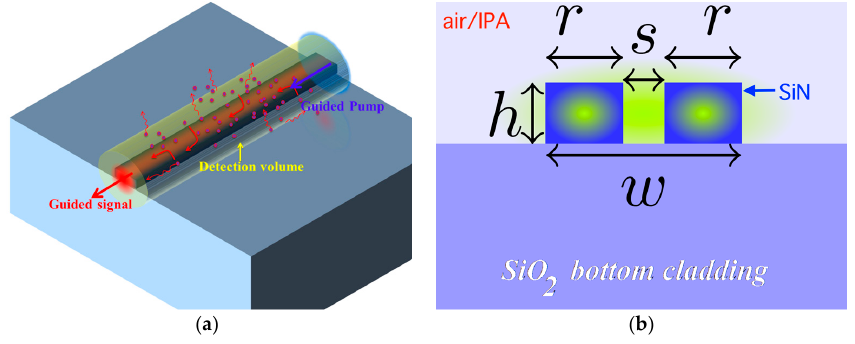
Figure 1. ( a ) Illustration of the nano-photonic waveguide enhanced Raman spectroscopy (NWERS) principle. The analyte is dispersed in the uppercladding, which is excited evanescently by a guided pump. The spontaneous Raman signal is collected by the waveguide evanescently. Adapted from [4], with permission from © 2016 The Royal Society; ( b ) A schematic of the cross-section of a generic silicon nitride (SiN) waveguide discussed in this paper. Slot waveguides are characterized by s > 0 while strip waveguides have s = 0. The top cladding (in light blue) may consist of Air, SiO 2 as in Figure 2d, or an arbitrary analyte for Raman sensing.